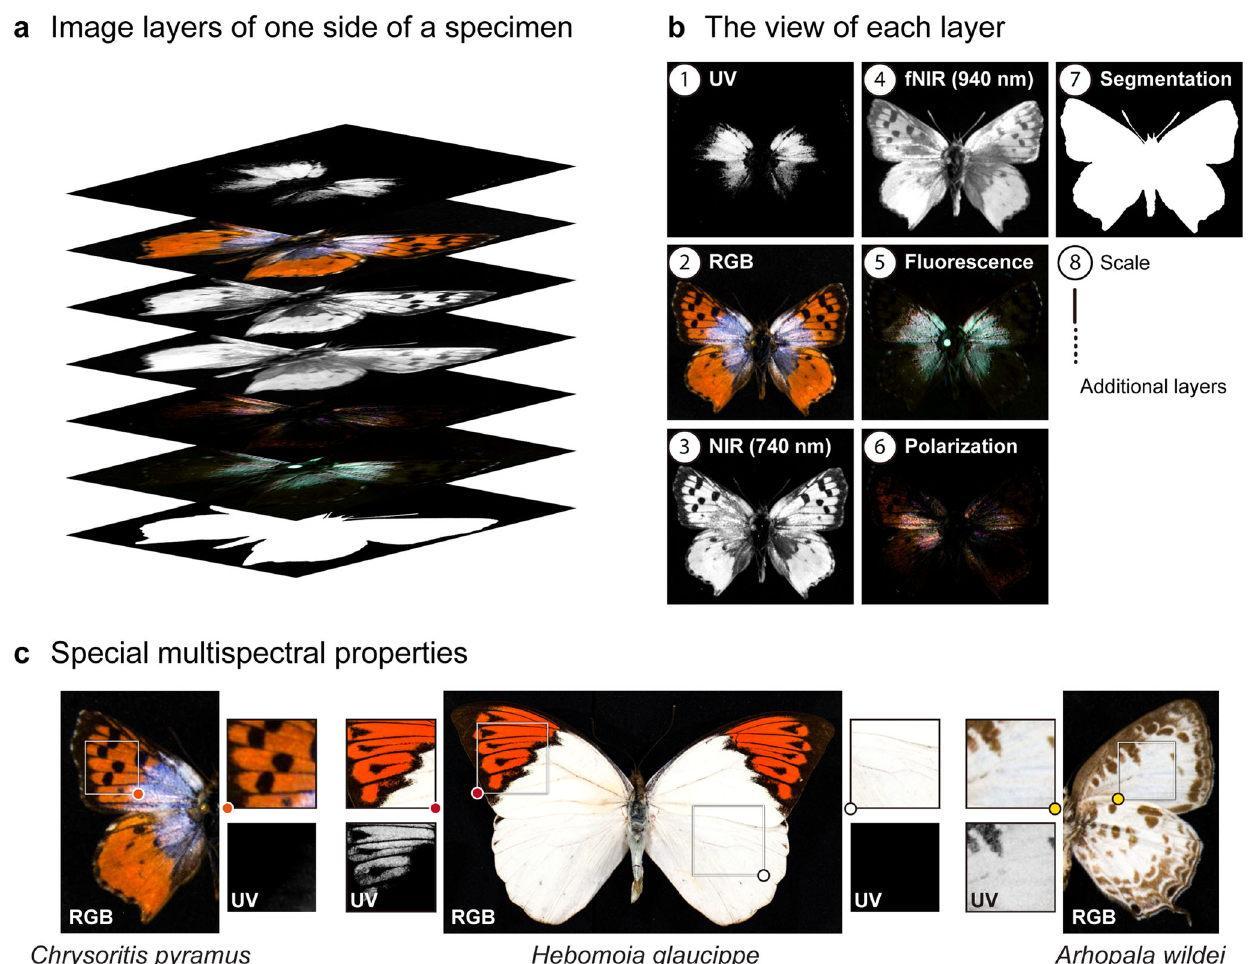
Fig. 8 The data structure of the initial descriptive data, with preliminary multispectral insights. a The multi-layer format ( “ cell format ” , the technical term used in MATLAB) is applied to contain the descriptive data for a single side of a specimen. b The appearance of some exemplar layers for the South African lycaenid, Chrysoritis pyramus . The actual output layer order can be found in the Supplementary Information. c Variation in scale properties affecting UV re fl ectance can be found within a single specimen of Hebomoia glaucippe , compared here with C. pyramus on the left and A. wildei on the